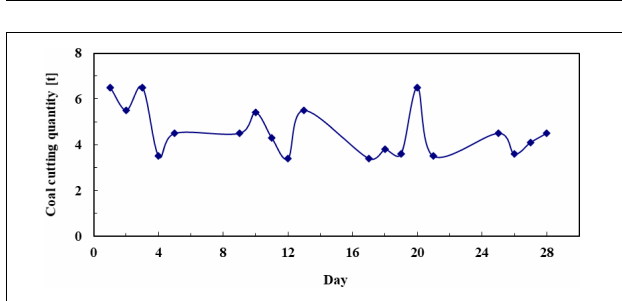
FIGURE 14 | Comparison of tunneling speed changes before and after flushing.